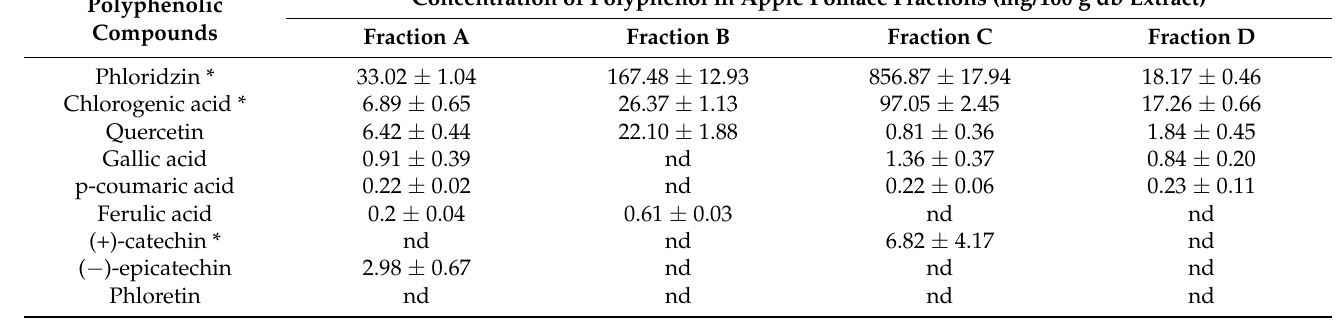
Table 4. Quantification of individual polyphenols of ethanolic extract from apple pomace fractions.